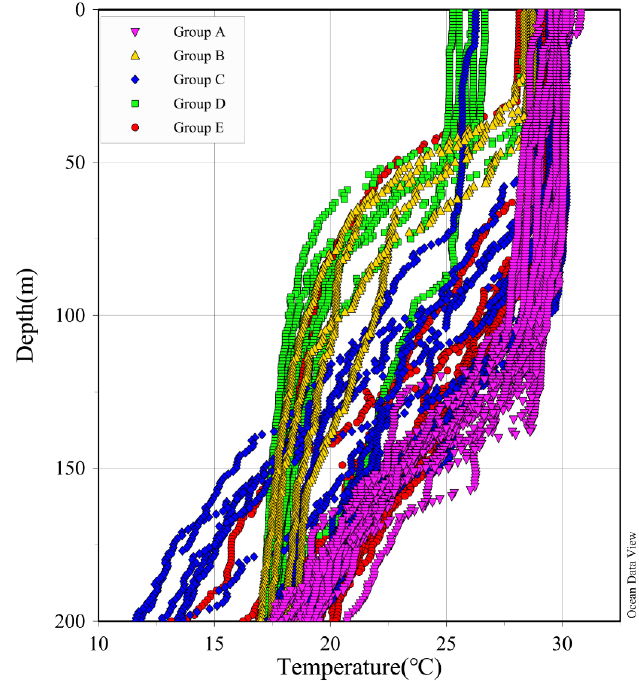
Figure 4. The temperature profiles of the upper 200 m at the survey stations to distinguish the five groups (Group A–E).